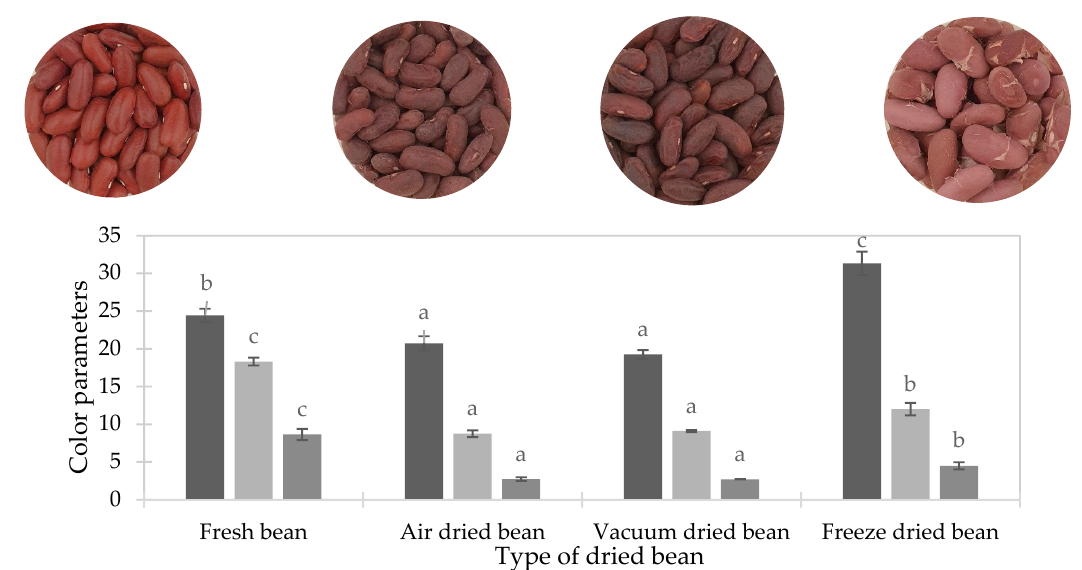
Figure 4. Color parameters L * ( (cid:4) ) a * ( (cid:4) ) and b * ( (cid:4) ) and visual appearance of dried beans and fresh beans. Parameters not